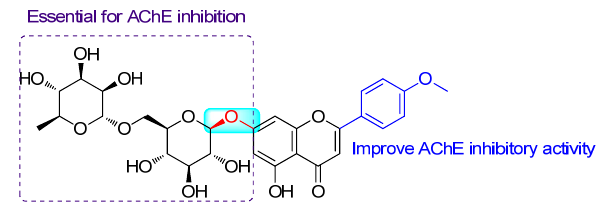
Figure 3. Structure–activity relationship of LN against AChE.